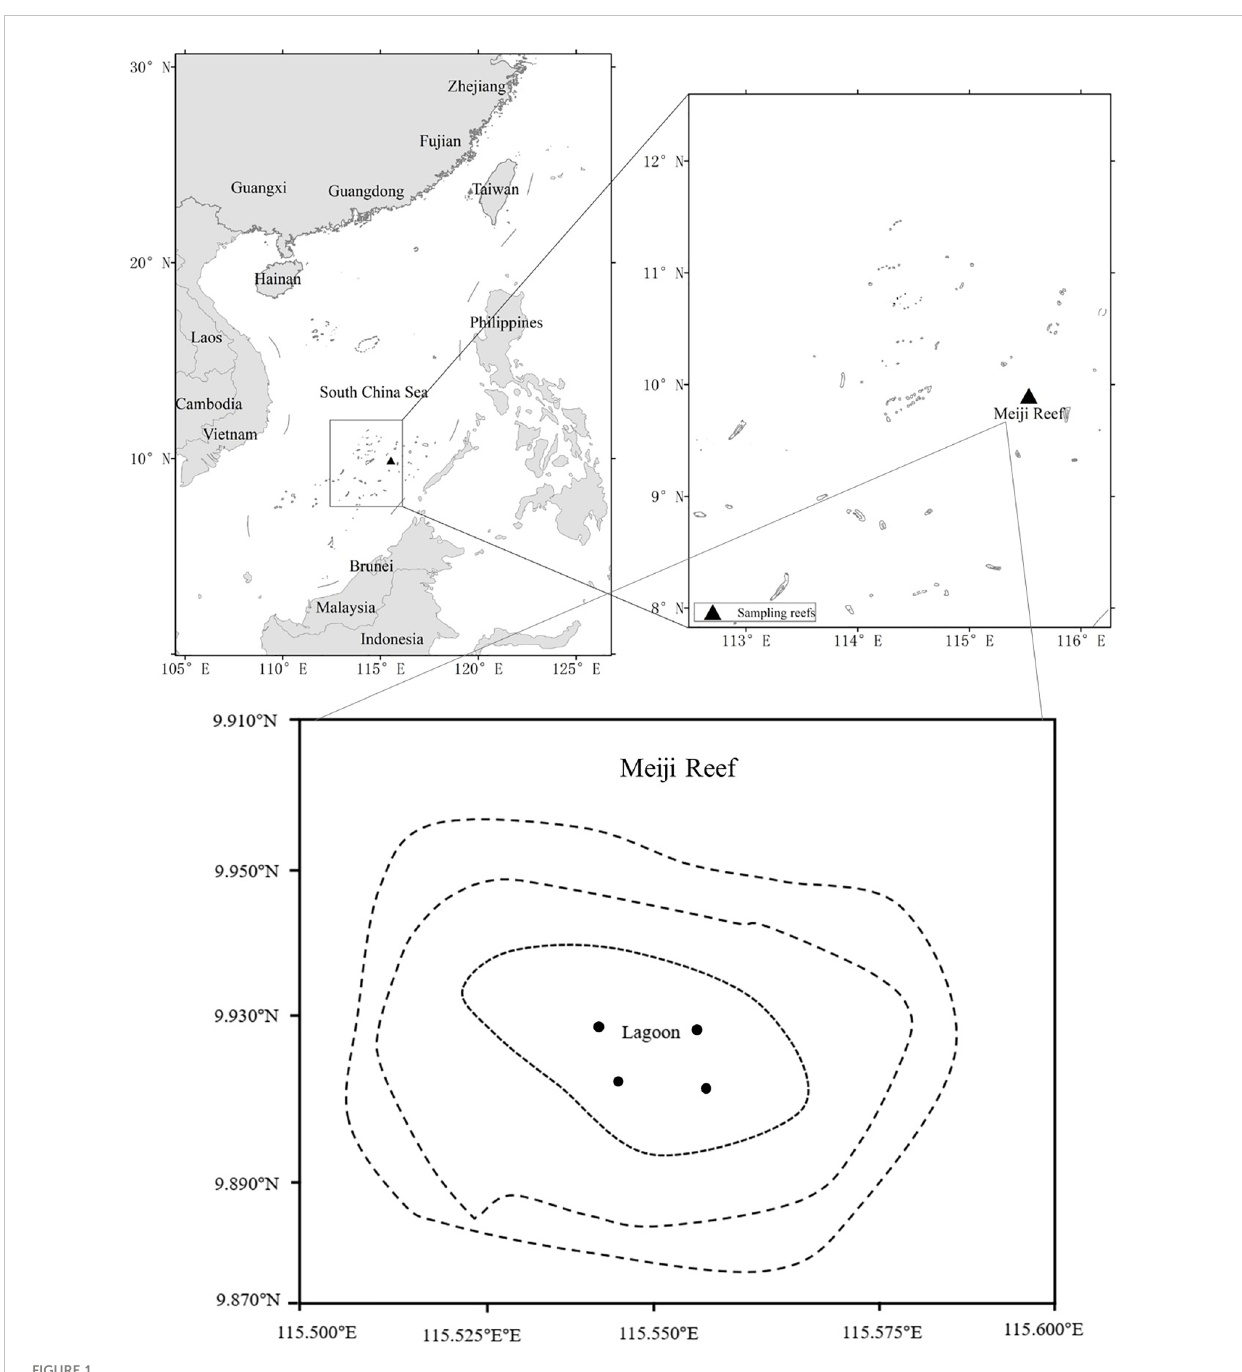
FIGURE 1 Study area (Meiji Reef lagoon) in the South China Sea. ● : approximate fi shing